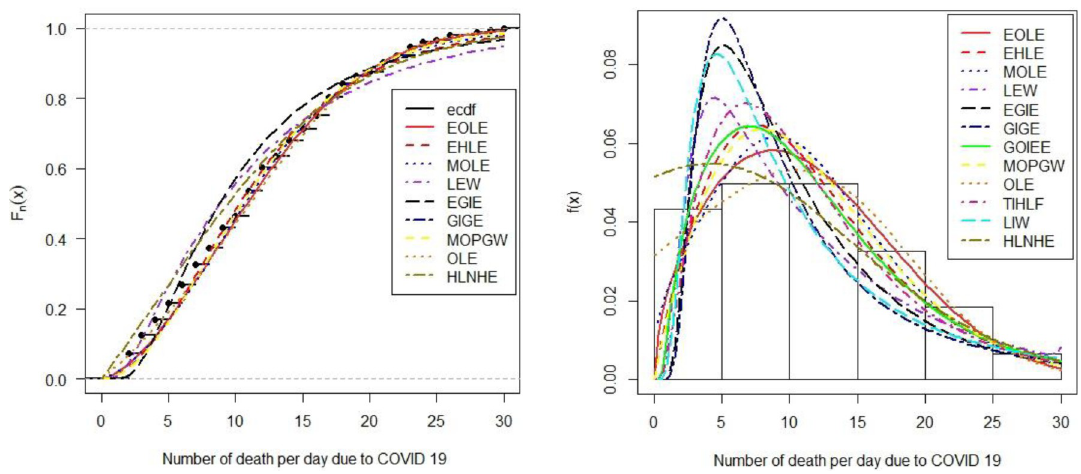
Fig 5. Estimated fitted CDF (left panel), Estimated fitted densities (right